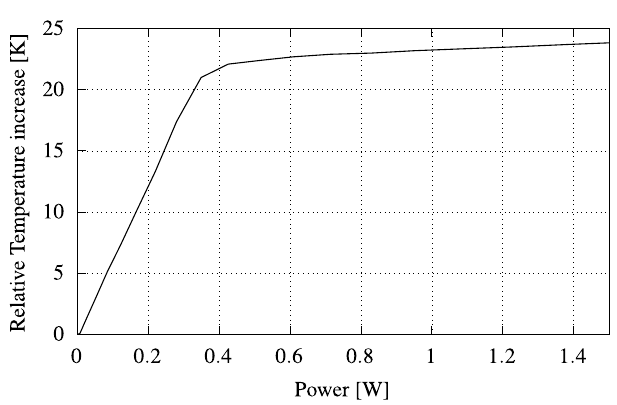
Figure 11. Temperature response of the printed micro heaters for a given